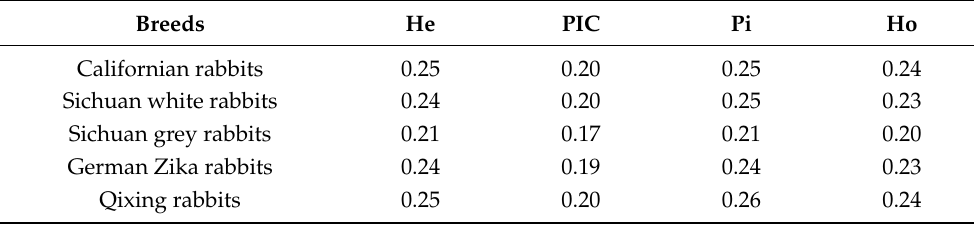
Table 1. Summary of F-statistics for all rabbit breeds.